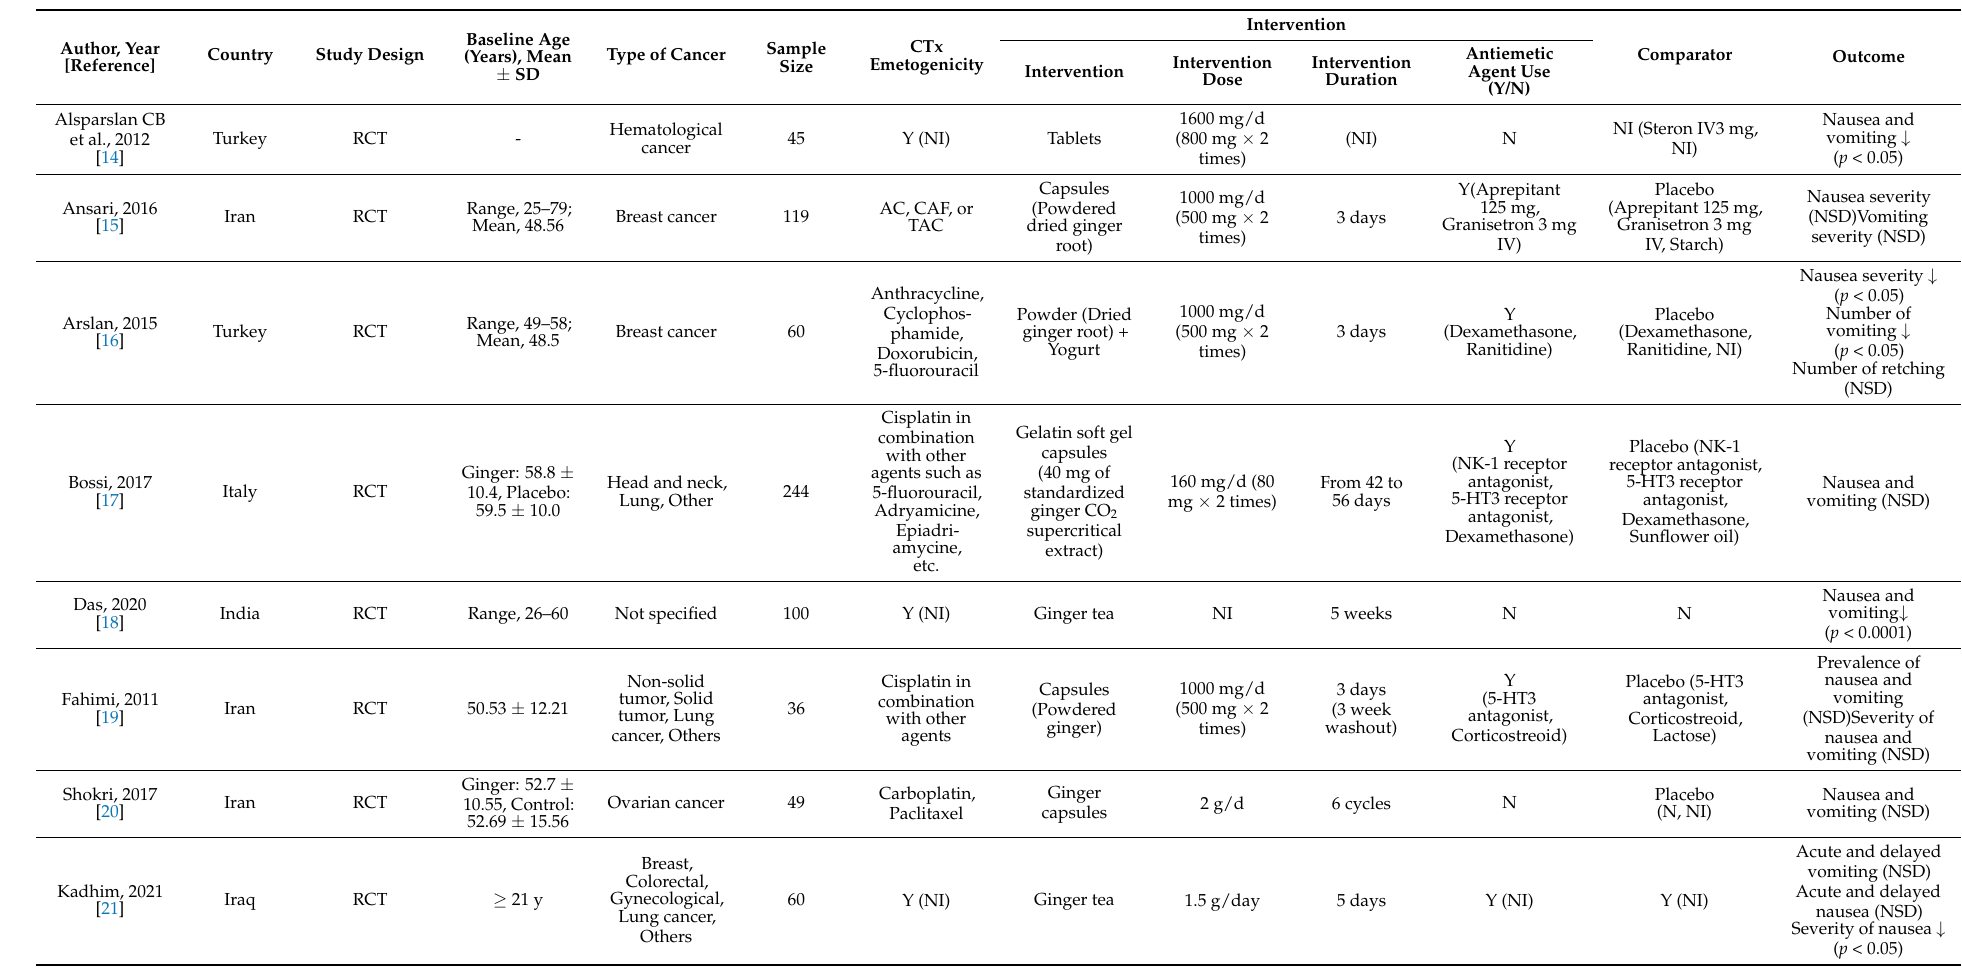
Table 1. Characteristics of the included